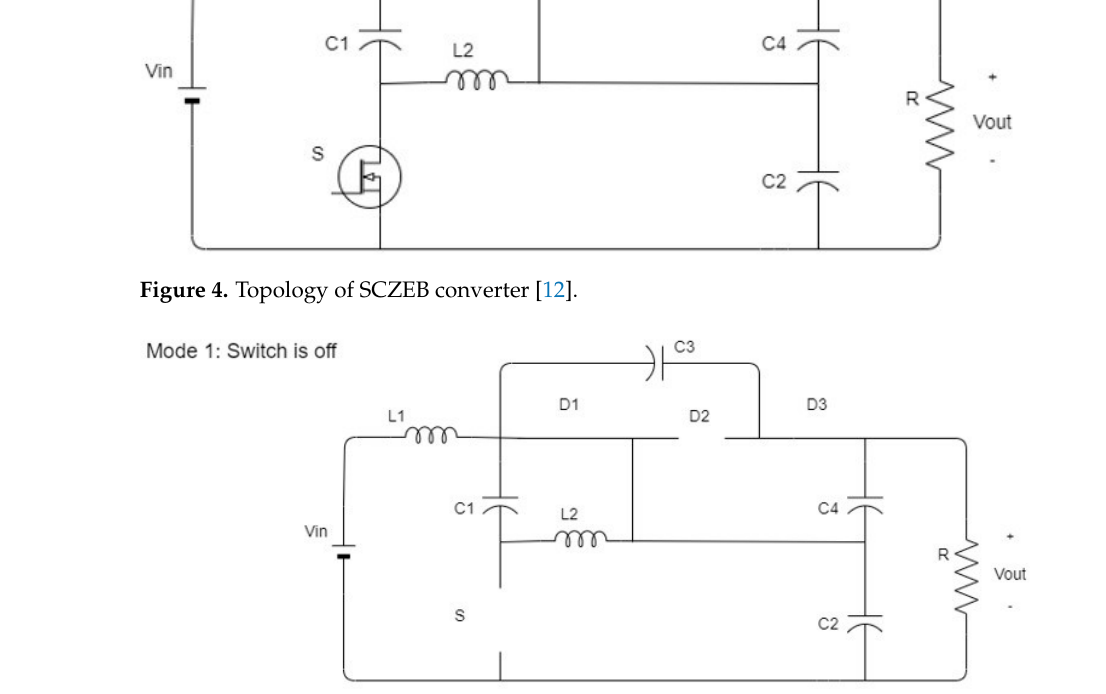
Figure 5. SCZEBC—Mode 1.